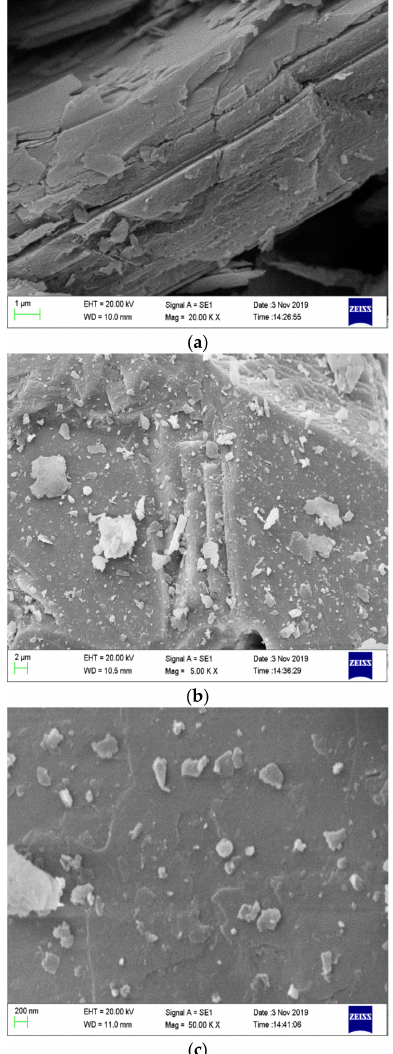
Figure 2. Scanning electron microscopy (SEM) photographs of char layer from PCMs after the CONE test. ( a ) PCM2, ( b ) PCM5, and ( c )